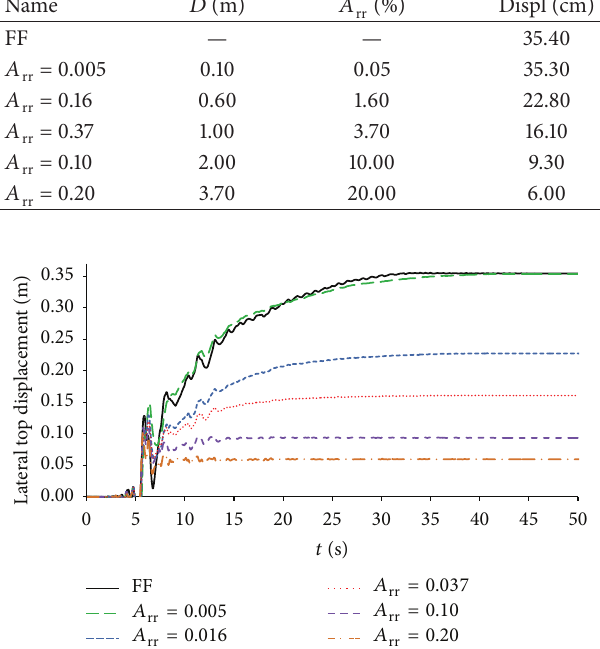
Table 5: Stone columns models. SC